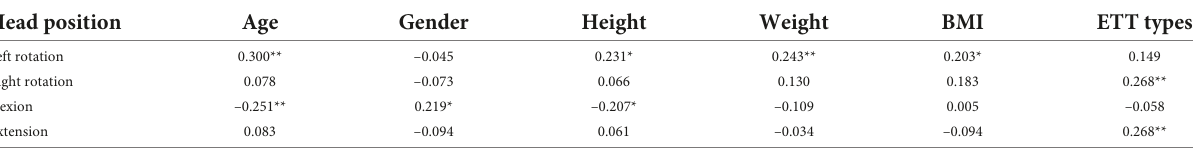
TABLE 5 Correlation of the distance of the ETT tip movement